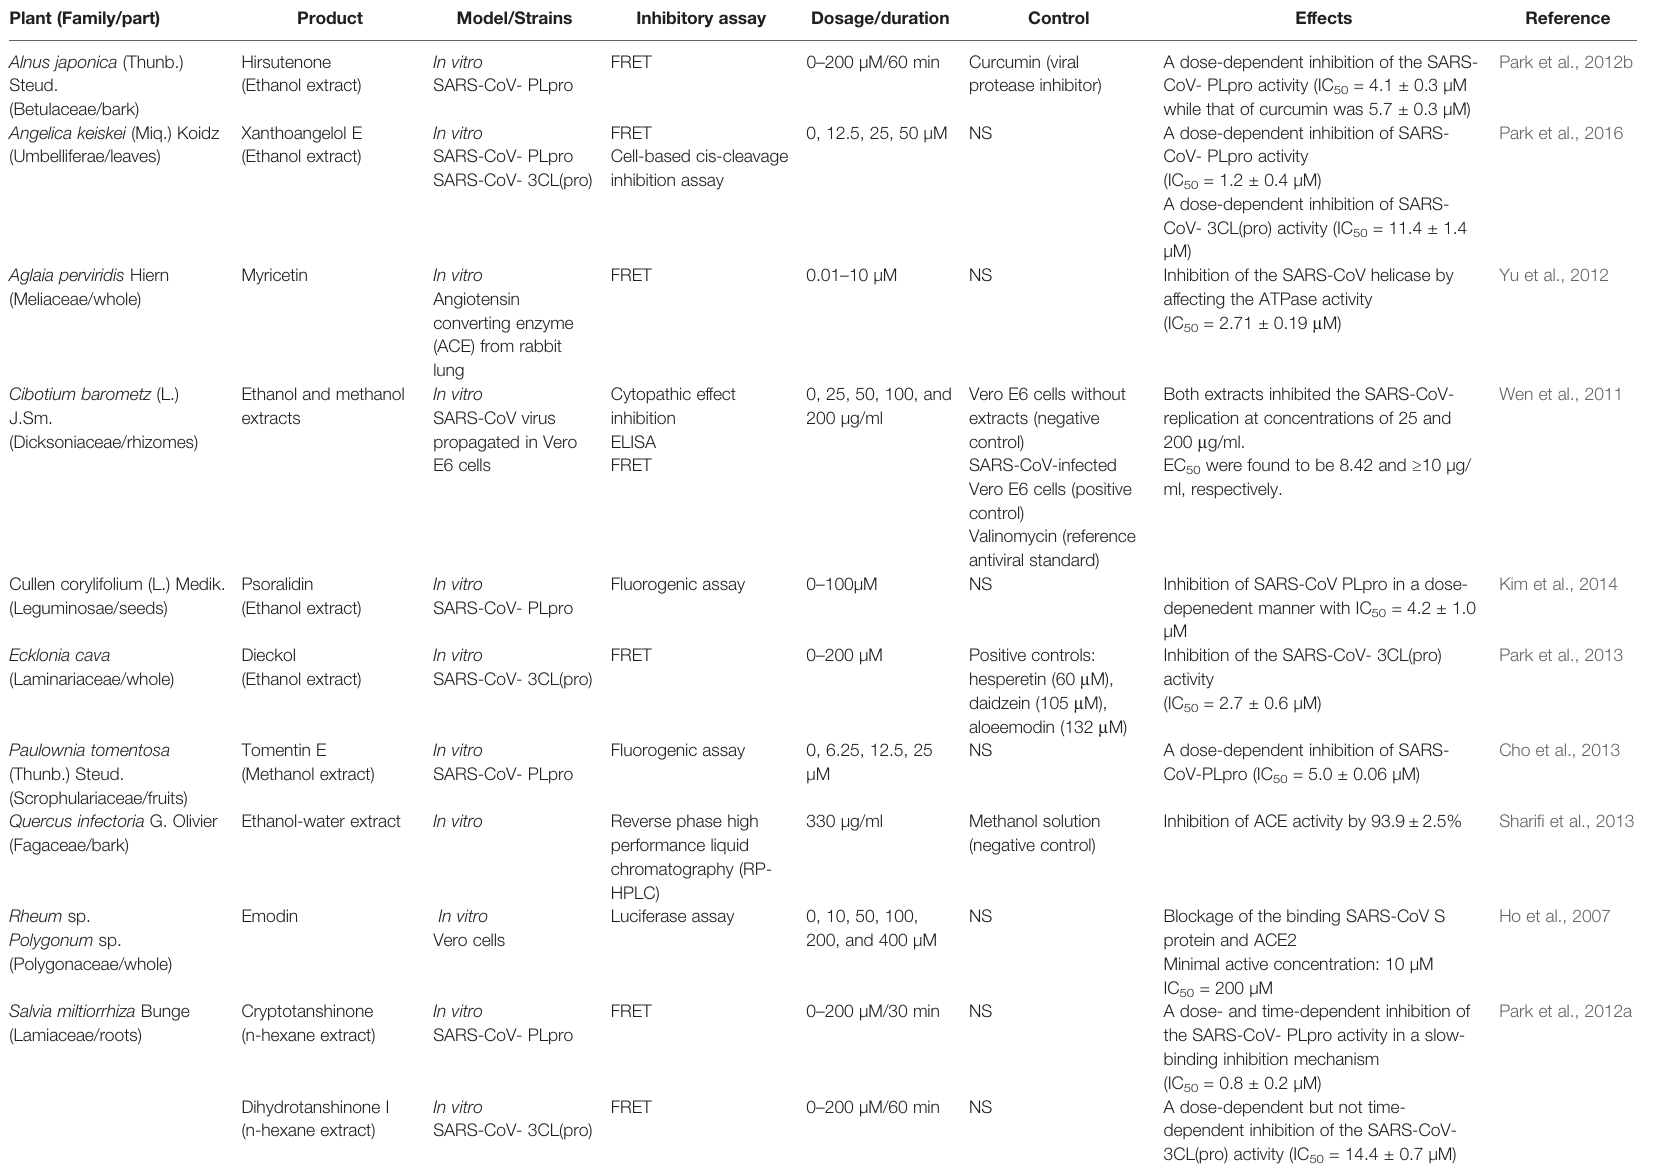
TABLE 1 | Natural products tested against